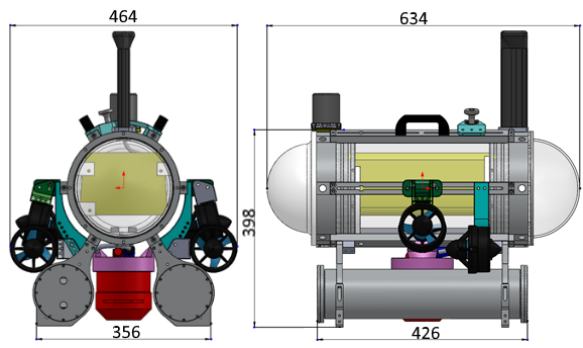
Figure 3. CAD design of FeelHippo